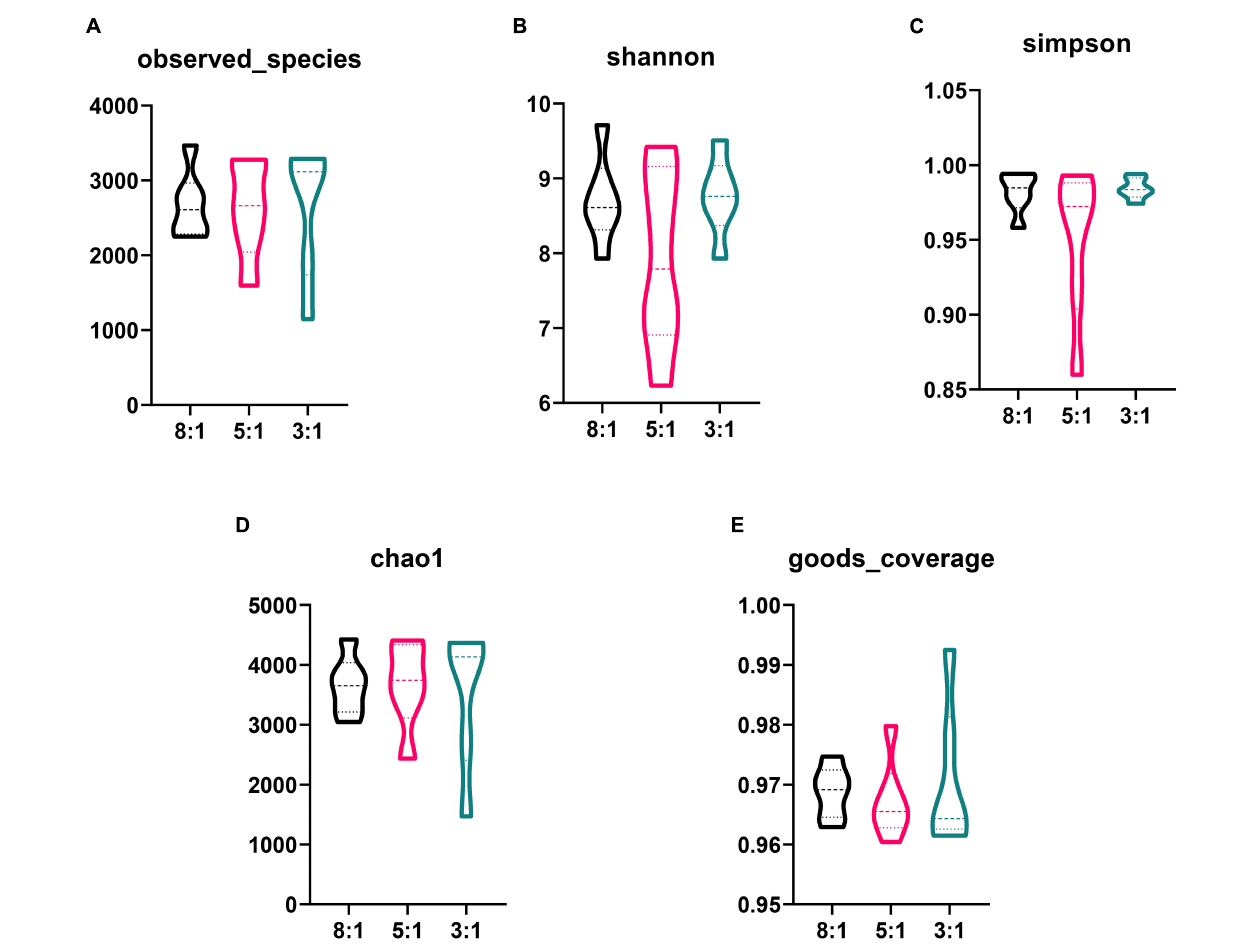
FIGURE 2 | Differences in the colonic bacterial α -diversity index after different n-6/n-3 PUFA ratio treatment. 8:1, 5:1, 3:1: different n-6/n-3 PUFA ratio diets. Data are presented as mean ± SEM ( n =